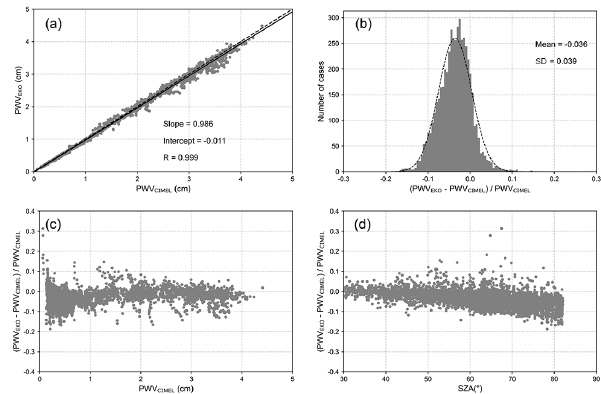
Figure 9. Mean and error bars of AOD at the wavelengths corre- sponding to the CE-318 filters were obtained using the method de- scribed in Sect. 3.3 for the spectral curves after overlaying the cali- bration uncertainties.